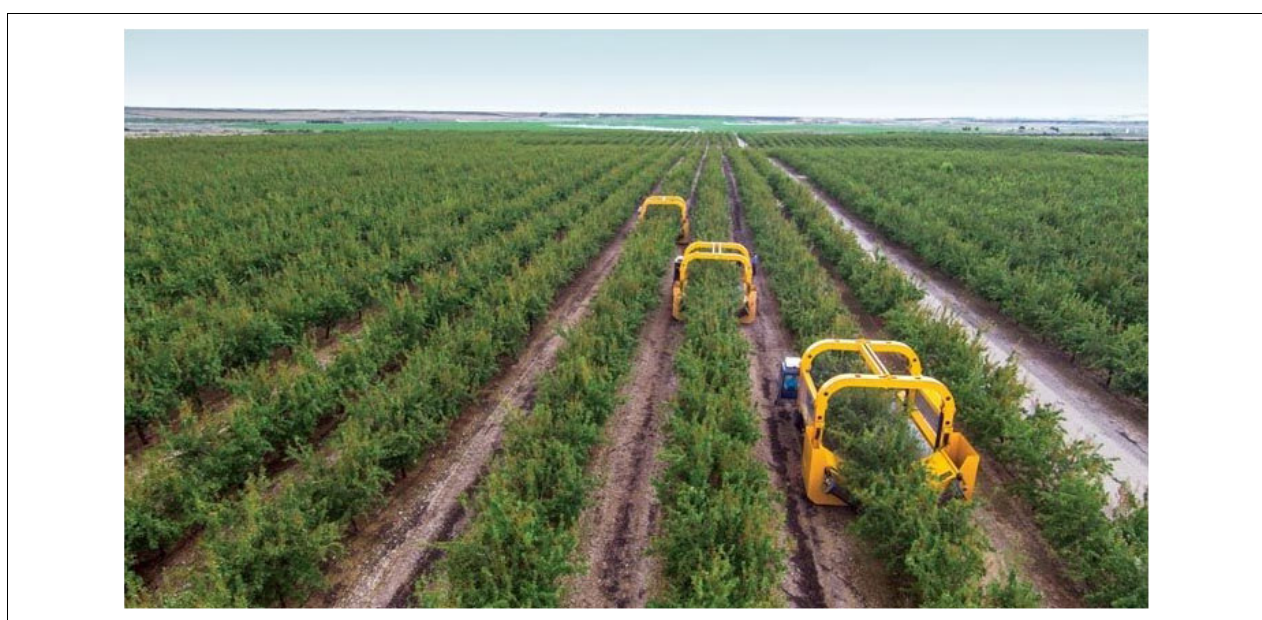
Frontiers in Plant Science |